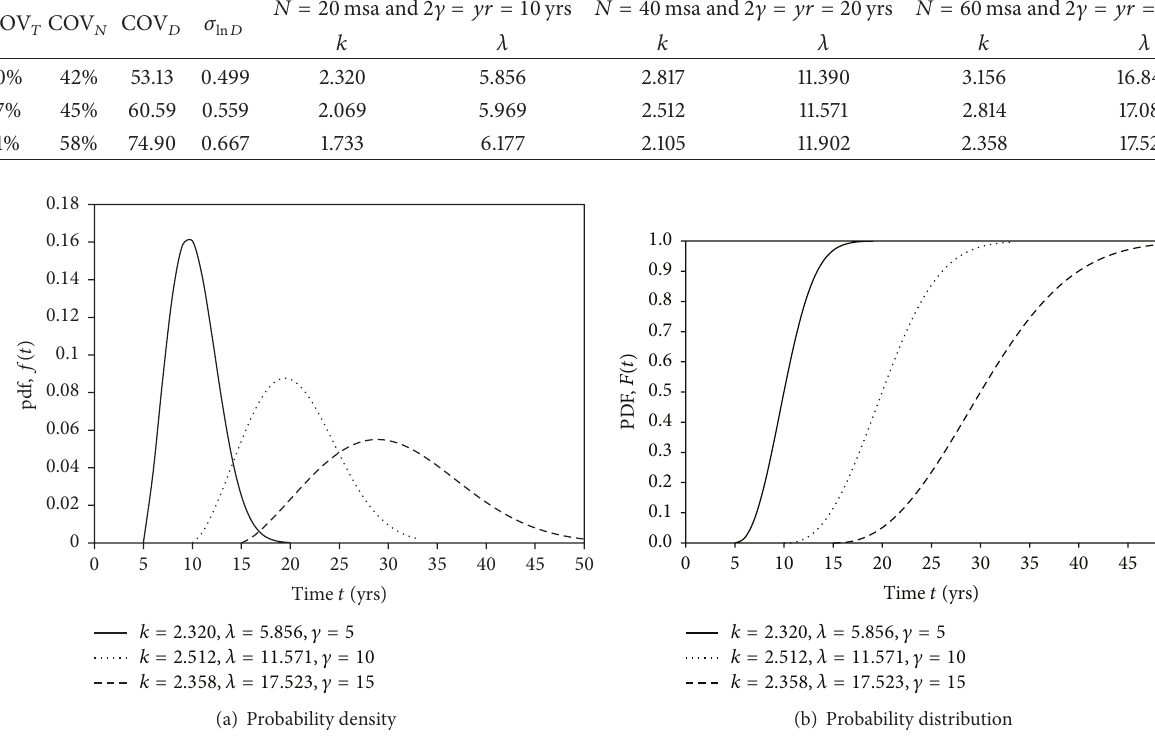
Figure 4: Probability density and probability distribution of failure time ( 𝑦𝑟 ).